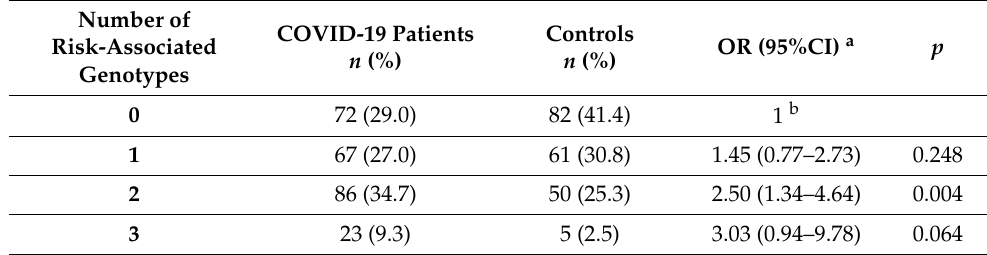
Table 5. Cumulative effect of COVID-19 risk-associated